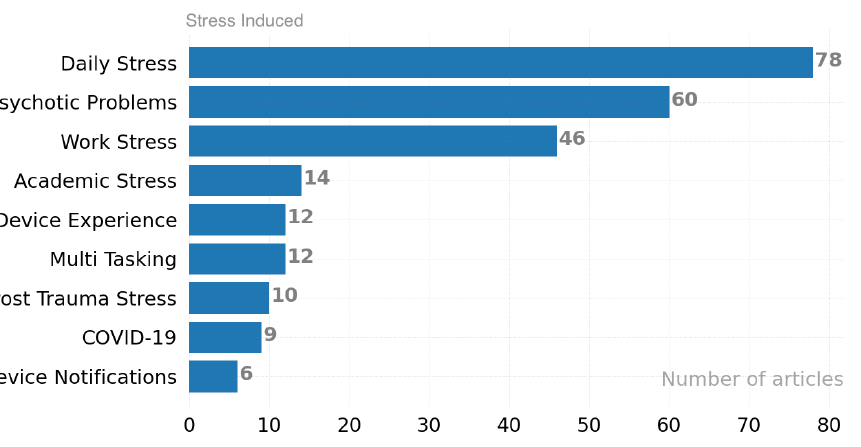
Figure 11. Triggering events that have been revealed. RQ 1.9: What was the average time spent on an experience sampling